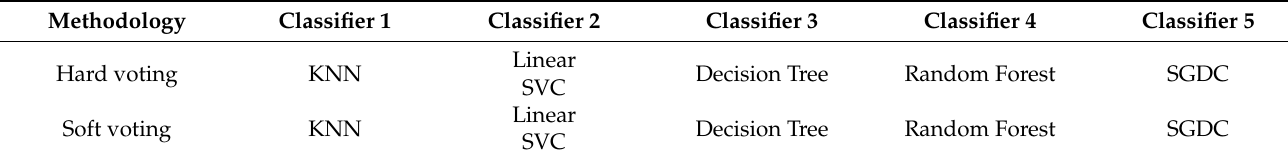
Table 3. Hard and soft voting base classifiers